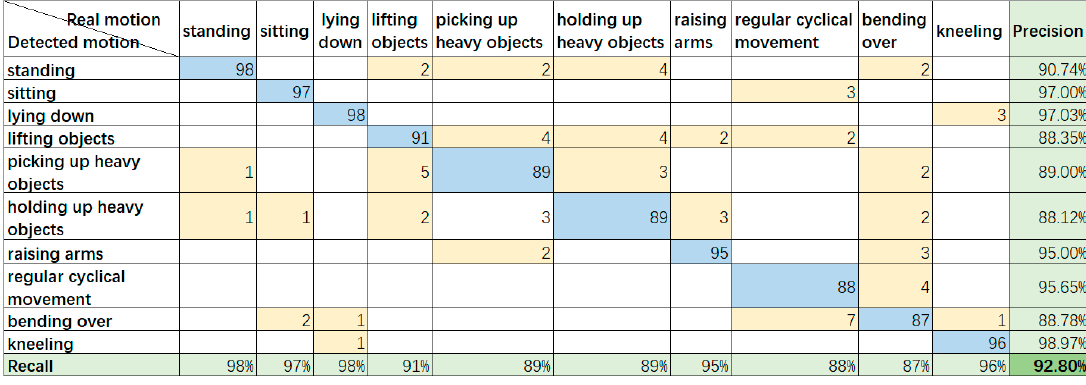
Figure 12. Simulation result for situation 3.